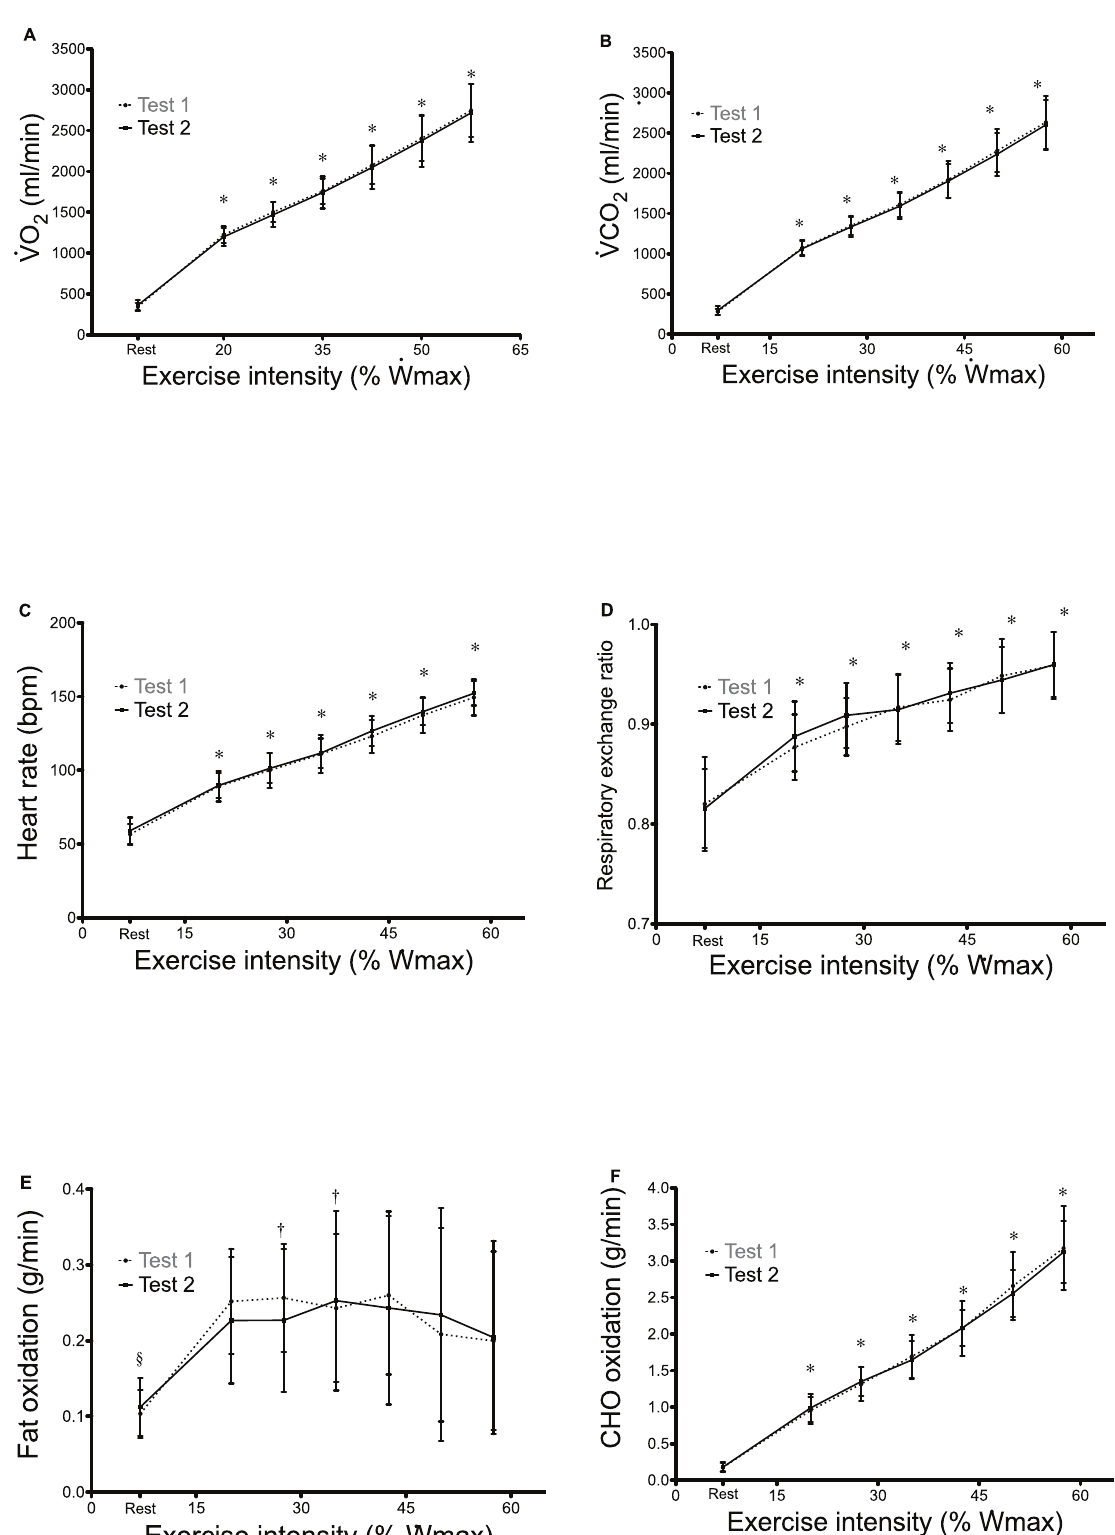
Figure 2. Course of average _ VVO 2 , _ VVCO 2 , HR, RER, F ox and CHO ox during two identical submaximal incremental tests (mean and SD). _(cid:2) W (cid:2) W _ VVO _ VVCO (cid:2) m (cid:2) a (cid:2) x , maximal aerobic power output; 2 , oxygen uptake; 2 , carbon dioxide production; RER, respiratory exchange ratio; HR, heart rate; F ox , fat oxidation rate; CHO ox , carbohydrate oxidation rate. *significantly increases with exercise intensity, 1 rest significantly different than exercise (20 – 57.5% _(cid:2) W (cid:2) W (cid:2) m (cid:2) a (cid:2) x \ ), { significantly different than 57.5% _ WW max .